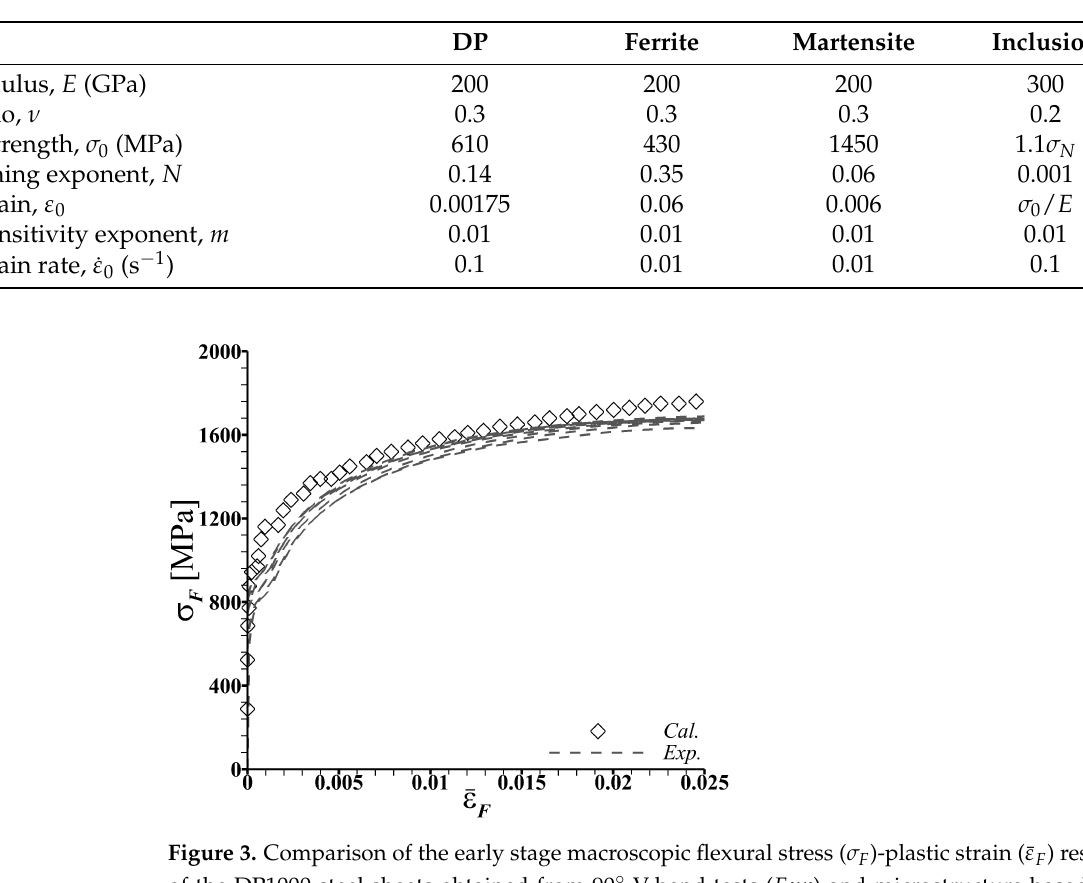
Table 1. The values of the constitutive parameters for the overall (homogenized) dual-phase (DP) steel [24], the individual constituent phases (ferrite and martensite) [24] and the non-metallic inclusion.